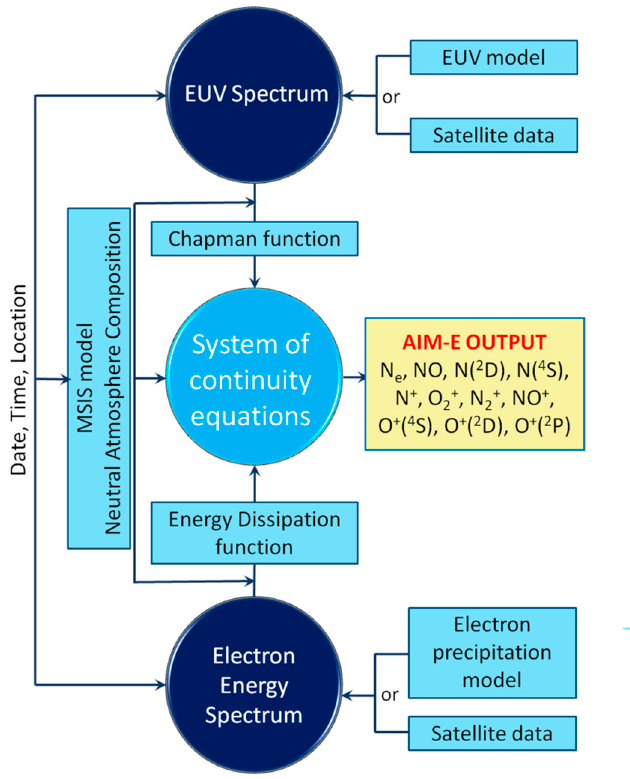
Figure 1. AIM-E model structure. Input parameters—date, time, and location—are used to calculate the altitude distribution of the ionization rates, utilizing three empirical blocks: NRLMSISE-00 for the neutral composition, EUVAC for the UV solar radiation spectrum and OVATION-Prime for the precipitating electron spectrum. Calculated distribution of ionization rates then go to the aeronomy block—the ODE solver for the system of continuity equation for 10 ionospheric species: neutrals NO, N( 4 S), and N( 2 D) and ions N + , O 2+ , N 2+ , NO + , O + ( 4 S), O + ( 2 D), and O + ( 2 P).